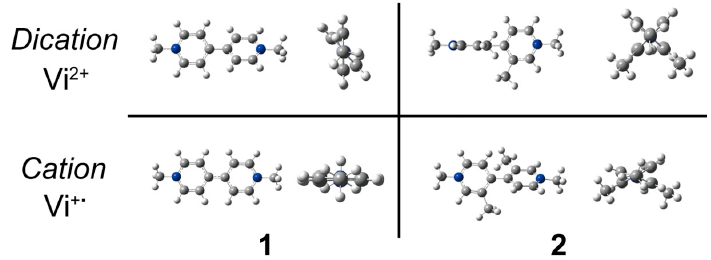
Figure 3. Estimated molecular structures for 1 and 2 in dication and cation states of bipyridine units. Density functional theory (DFT) calculation was used for structure optimization.